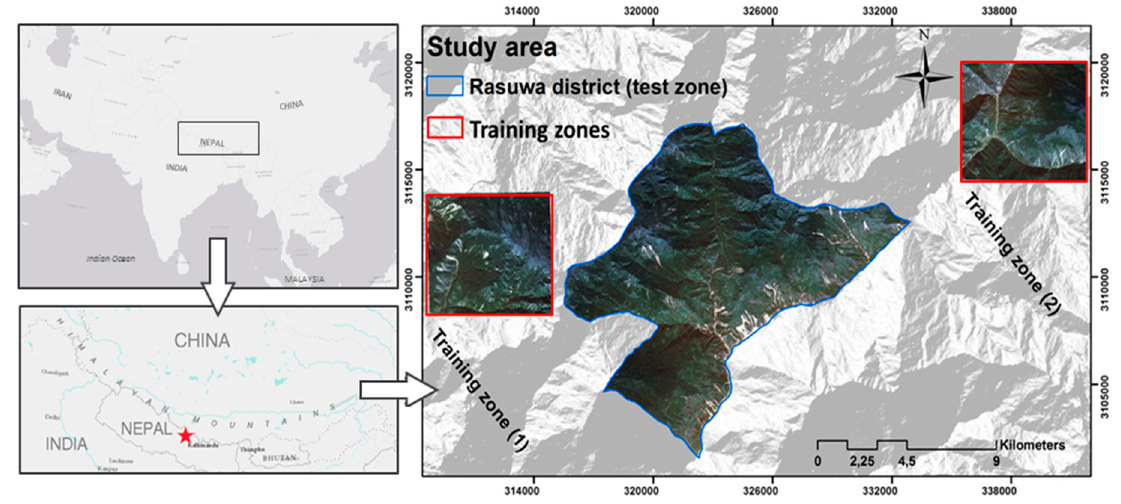
Figure 1. A true color composite of RapidEye bands 3/2/1 acquired on 18 June 2015, illustrating the geographic location of the study area. Table 1. Landslide inventories prepared as part of different